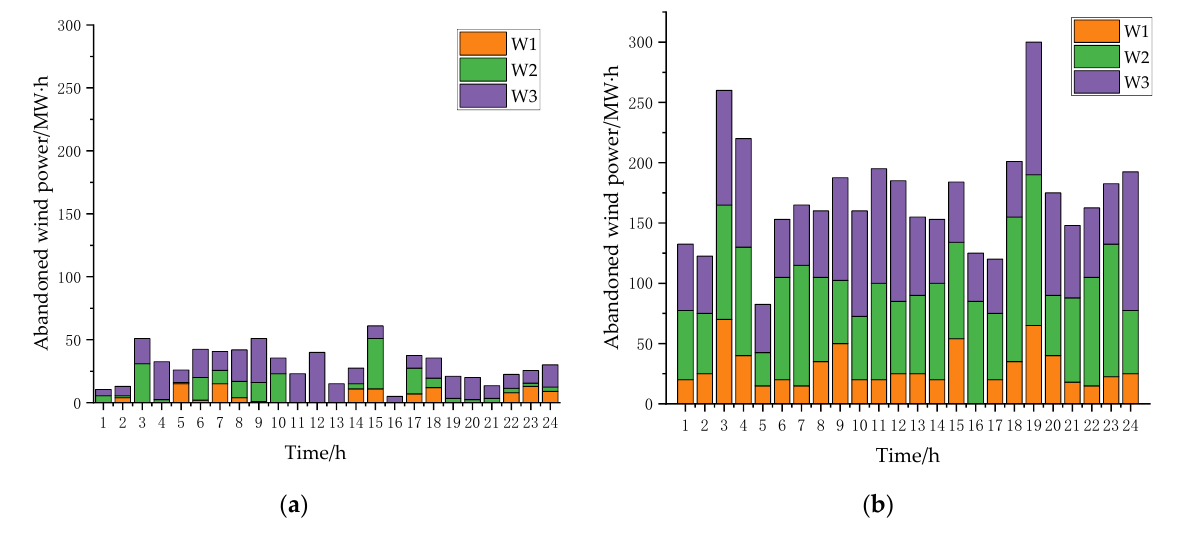
Figure 12. ( a ) Case 1 Wind farm curtailment of wind power; ( b ) Case 2 Wind farm curtailment of wind power.